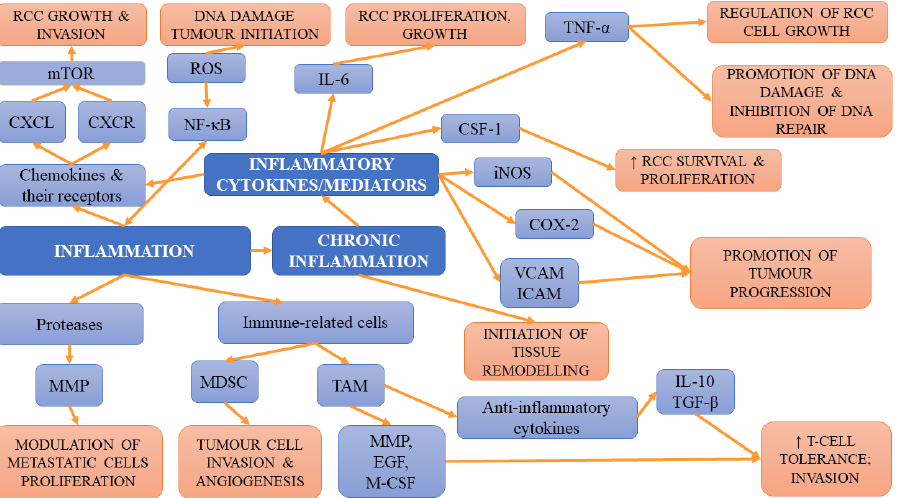
Figure 2. The summary of inflammation-related mechanisms involved in tumour initiation, progression and metastases .